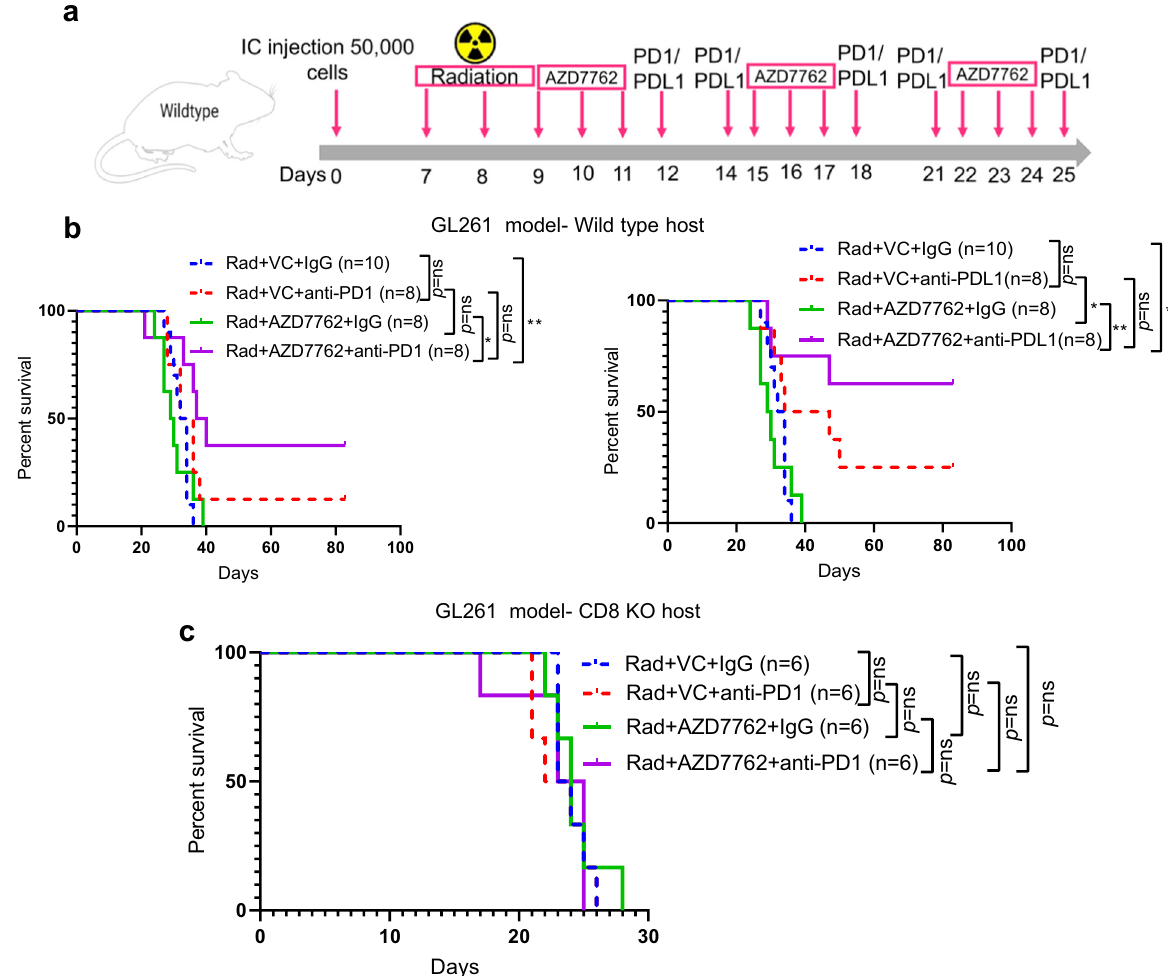
Fig. 9 | The combination of radiotherapy, AZD7762 and PD-1/PD-L1 blockade improves the survival of glioma-bearing mice in GL261 glioma model. a The schematic representation of the dosing scheme followed for the survival experi- ment. b